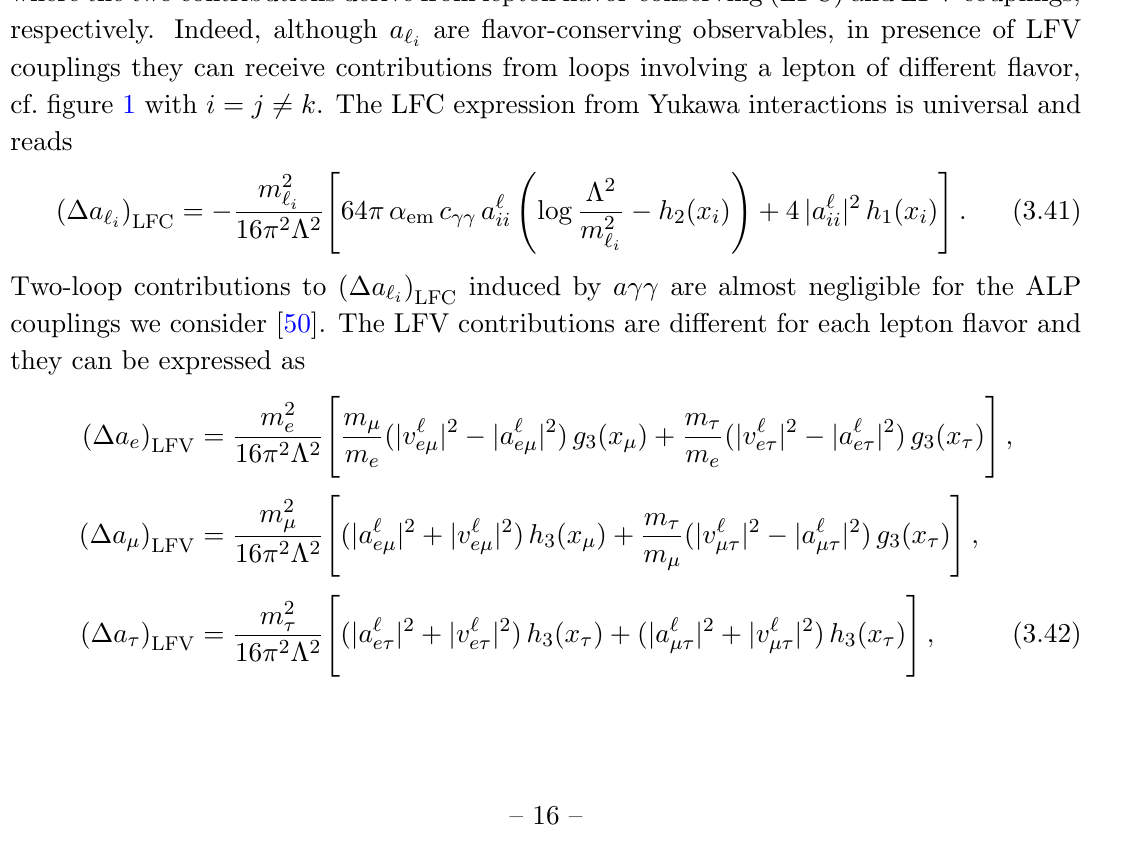
is the only non-vanishing LFV (cid:22)e